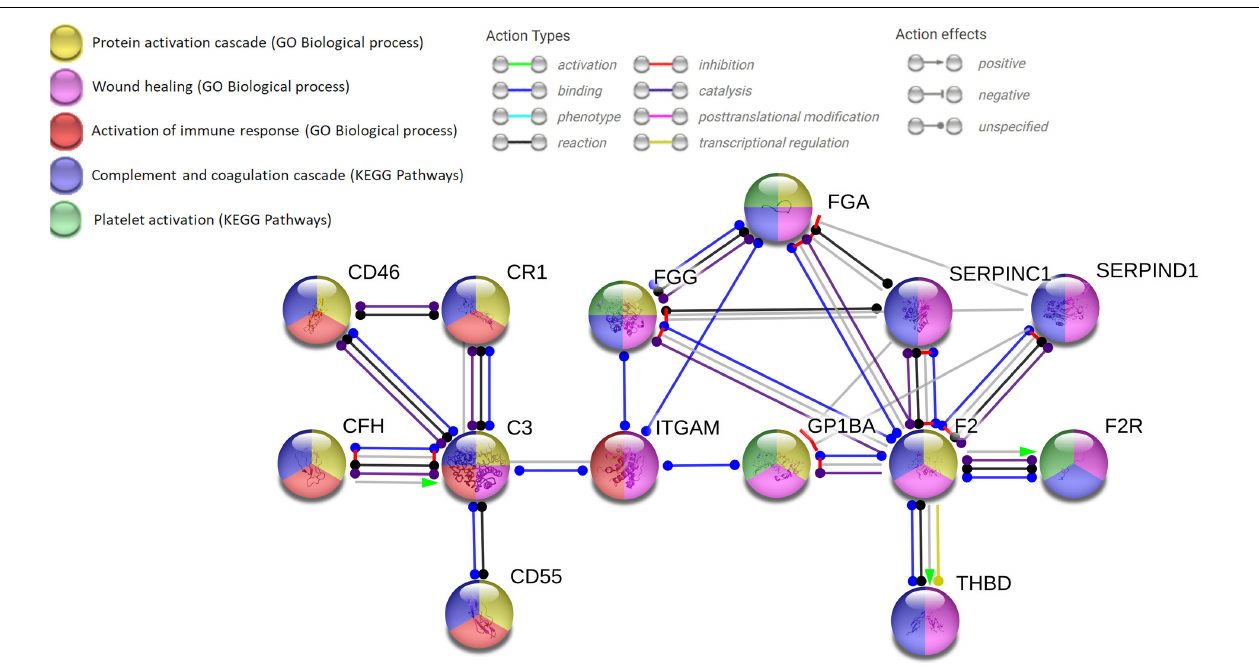
FIGURE 3 | Network analysis using the string.org platform for protein–protein interactions (PPIs) which integrates Gene Ontology (GO) and Kyoto Encyclopedia of Genes and Genomes (KEGG) database. The databases query demonstrates the solid neuro-immune hemostatic network with the pivotal hubs strictly interconnected and the expandable hub-spoke associations. Four input proteins (F2, C3, ITGAM, GP1BA) with 14 nodes and 23 edges (minimum required interaction score: highest confidence 0.900; PP1 enrichment p -value of 0.00103). C3, complement component 3; CD, cluster of differentiation; CFH, complement factor H; CR1, complement component (3b/4b) receptor 1; FG, fibrinogen: alpha (FGA) or gamma (FGG) chain; F2, thrombin; F2R, protease-activated receptor-1 (PAR-1); ITGAM, integrin α M (C3 receptor 3 subunit); THBD, thrombomodulin; SERPINC1, serpin peptidase inhibitor, clade C member 1 (antithrombin III); SERPIND1, serpin peptidase inhibitor, clade D member 1 (heparan